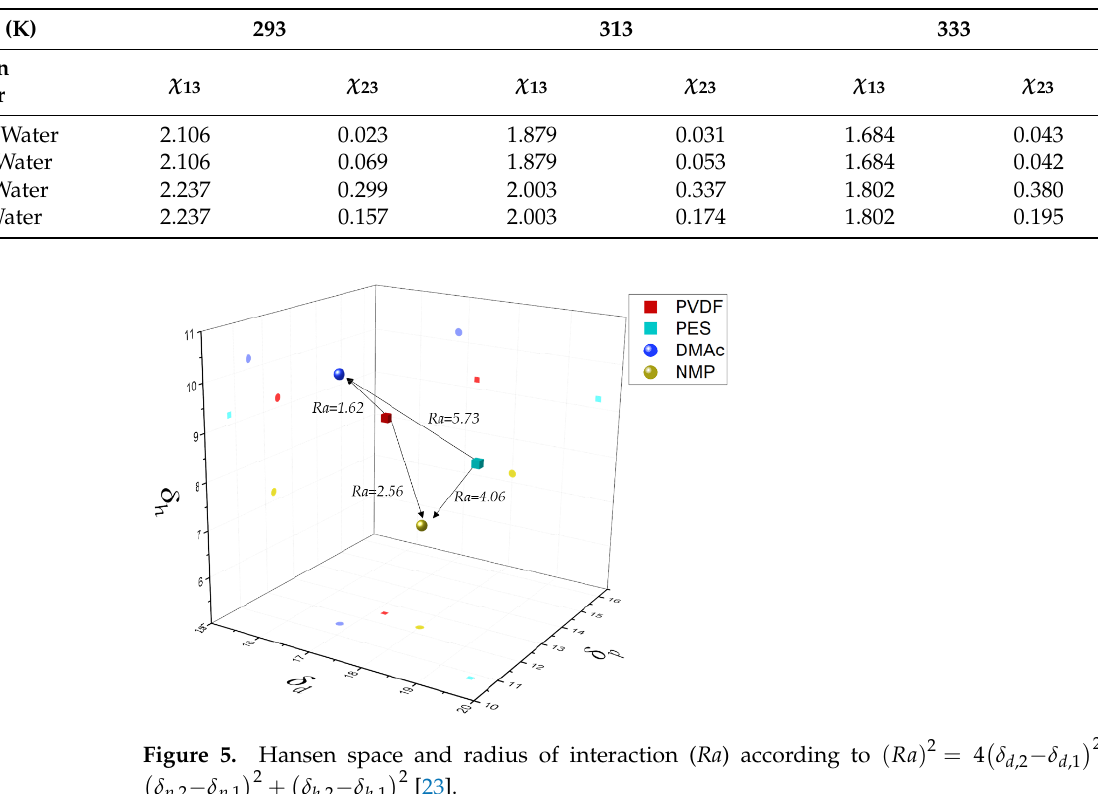
+ ( δ p,2 - Figure 5. Hansen space and radius of interaction ( Ra ) according to ( Ra ) 2 = 4 (cid:0) δ d ,2 − δ d ,1 (cid:1) 2 +